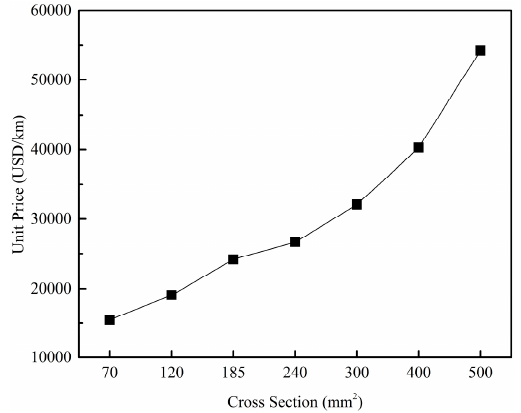
Figure 1. Unit price of the cable.